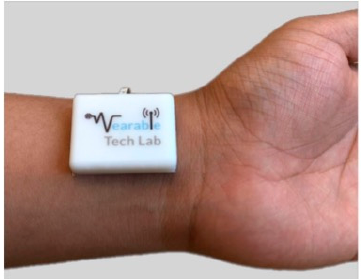
Figure 8. Wearable device to monitor the heart sound at the wrist. The device is composed of a MEMS microphone sensor integrated with Bluetooth. Open Access [78] © 2022 Nature Publishing Group.